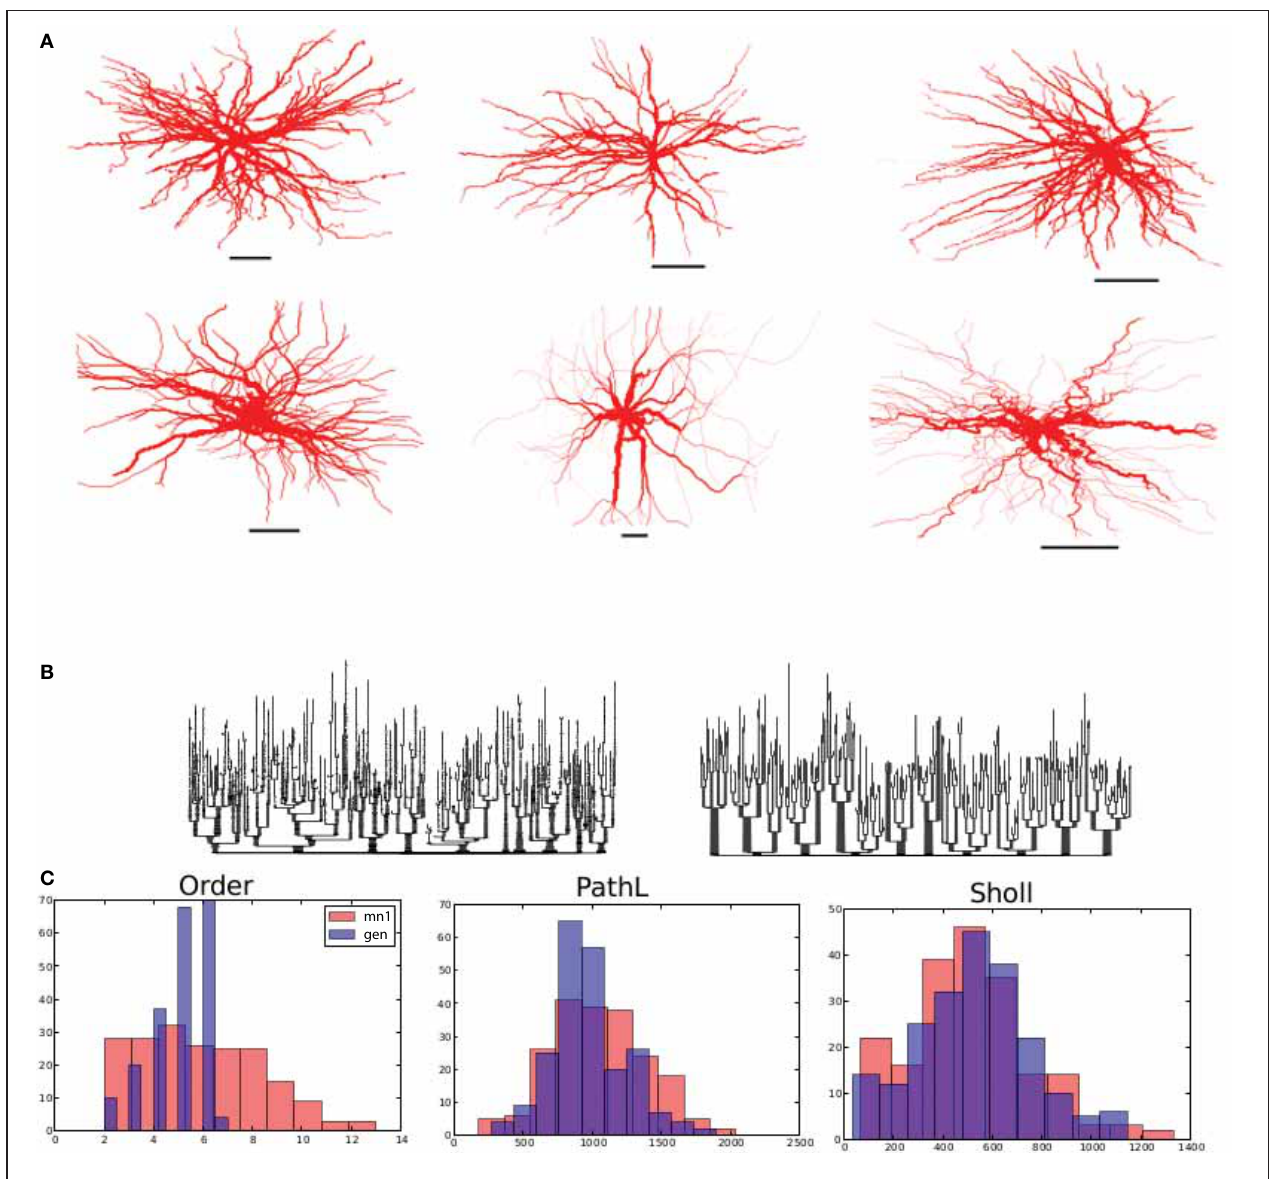
respectively. (C) Comparison between reconstructed and generated motor neurons based on their measured distribution of the branching order, path lengths to terminal tips, and Sholl-intersections. Scale bars in (A) indicate 250 μ